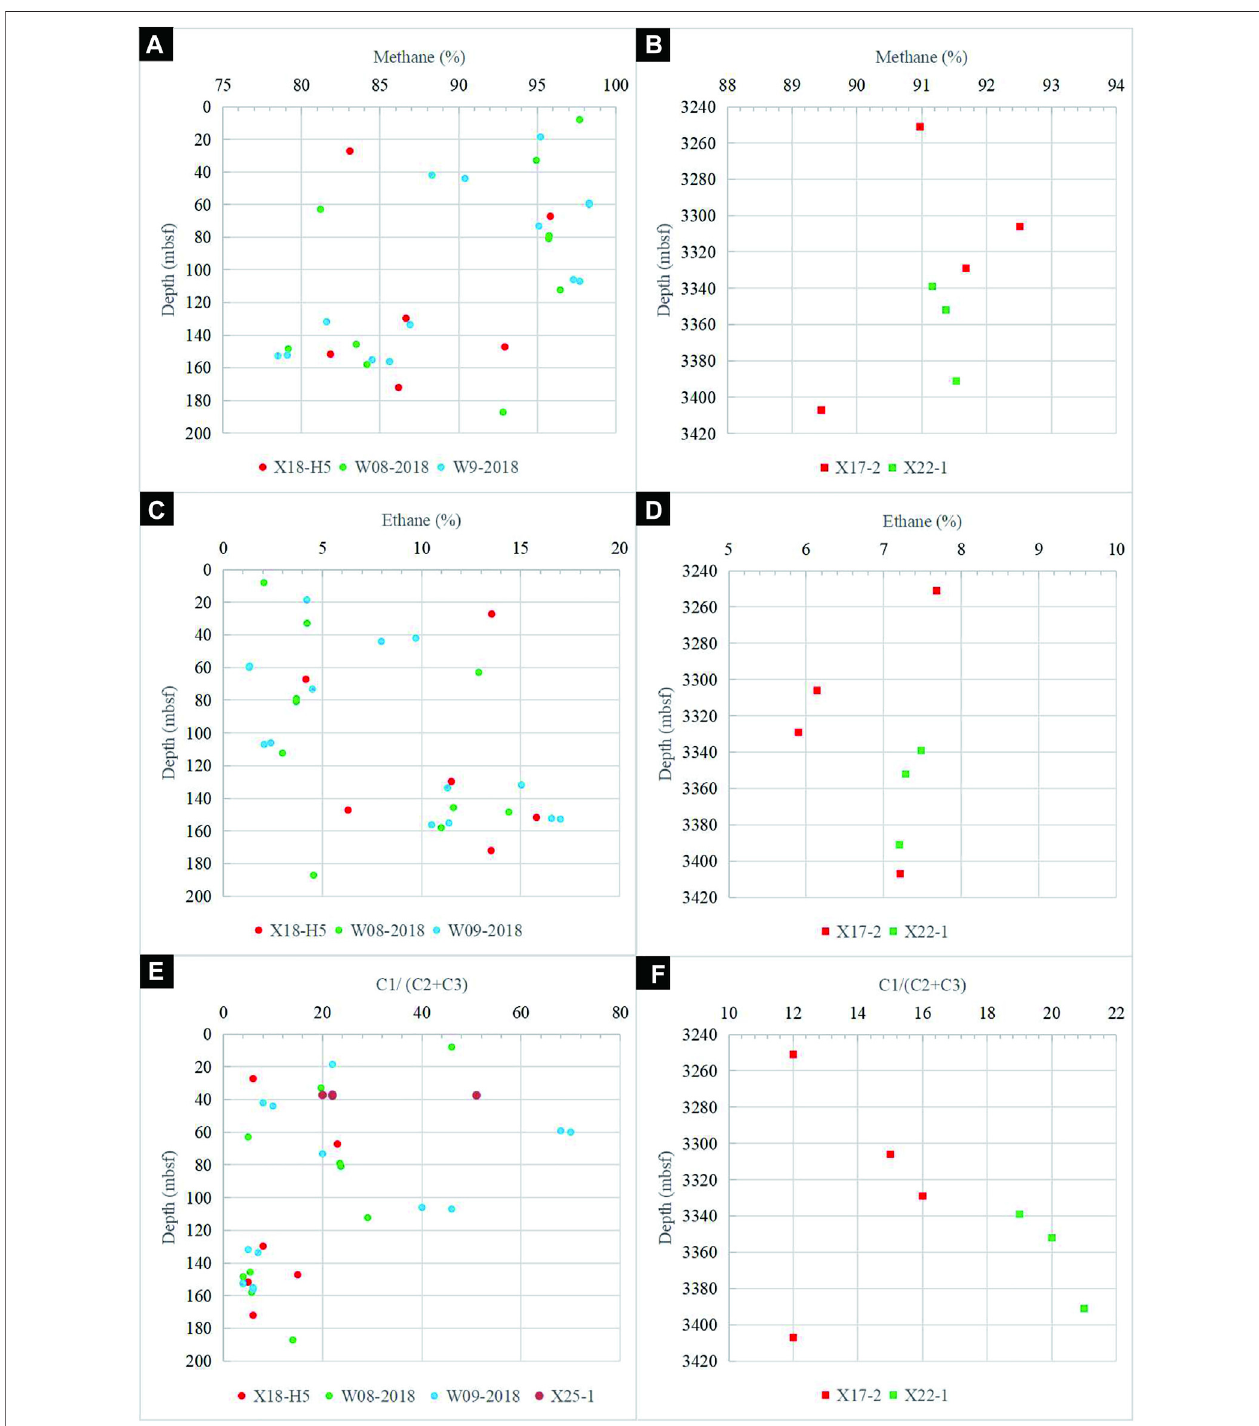
FIGURE 3 | Gas content at different depths at different sites (A,B) Methane; (C,D) Ethane; (E,F) C1/(C2+C3))